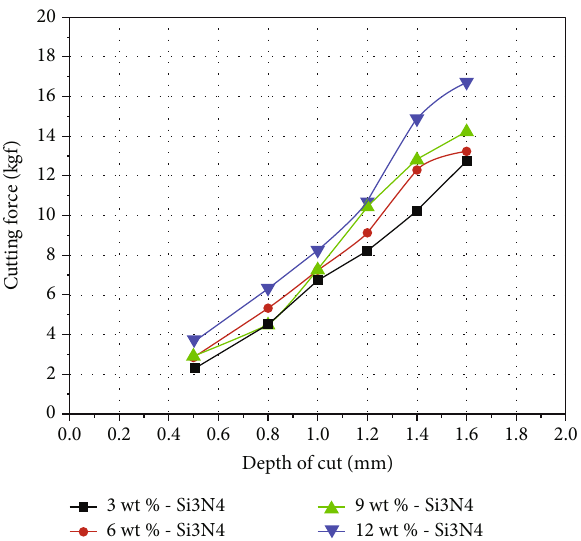
Figure 5: Depth of cut vs. cutting force (cutting speed 50m/min). Table 6: Cutting force summary (cutting speed 100 m/min). S. no Depth of cut (mm)